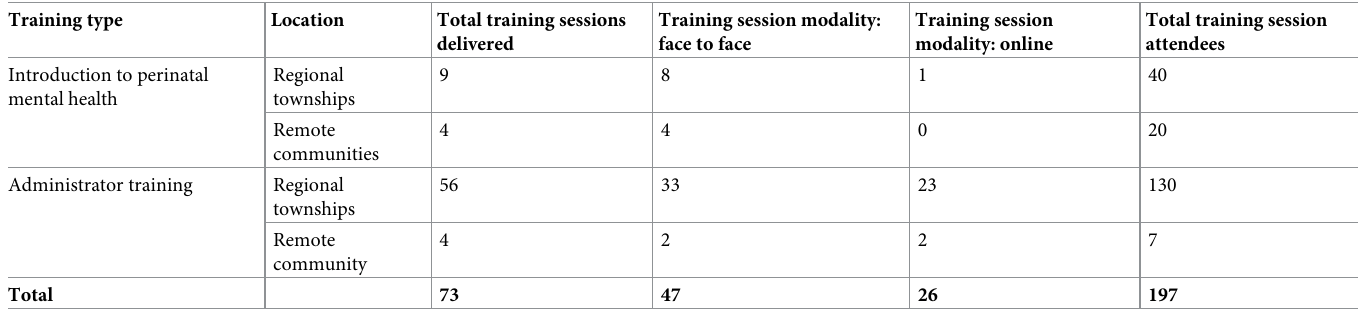
Table 3. Kimberley Mum’s Mood Scale 2019–2021 training sessions and number of attendees by